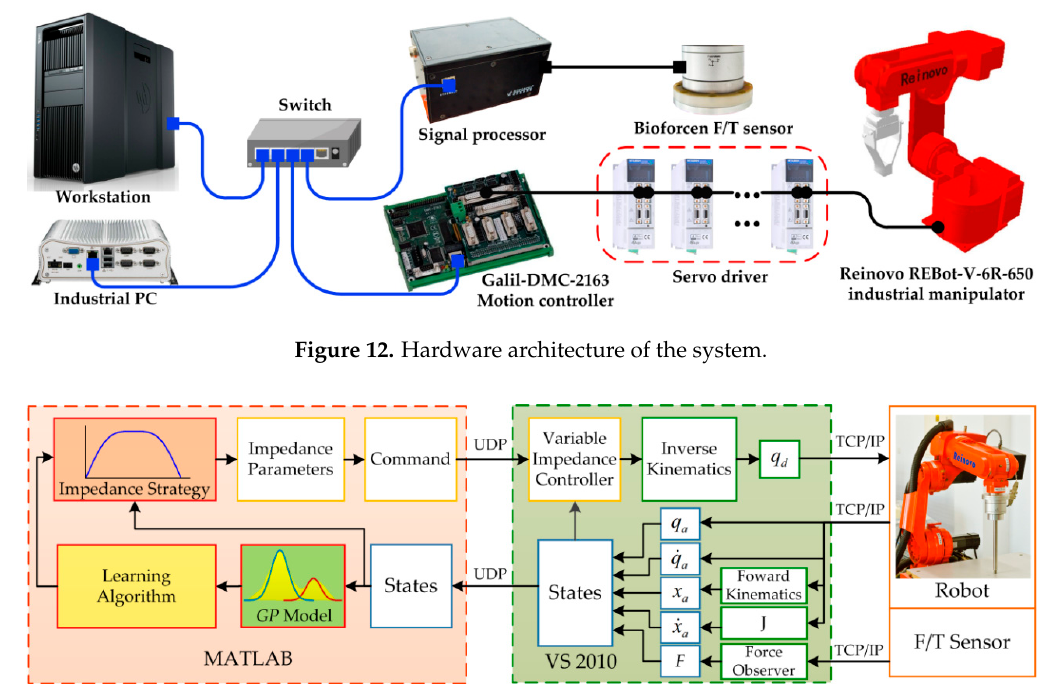
Figure 13. Implementation diagram of the algorithm.